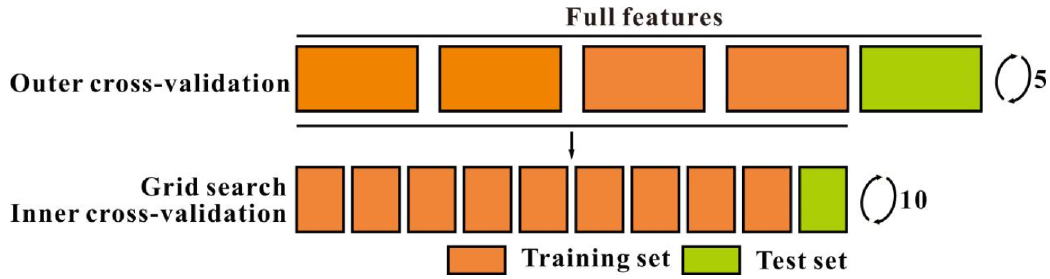
Figure 4. Five-fold cross-validation internal and external cross-validation